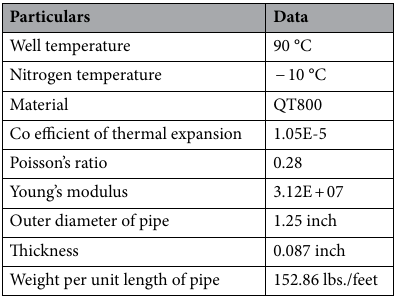
Table 18. Information on a nitrogen shooting operation using CT.